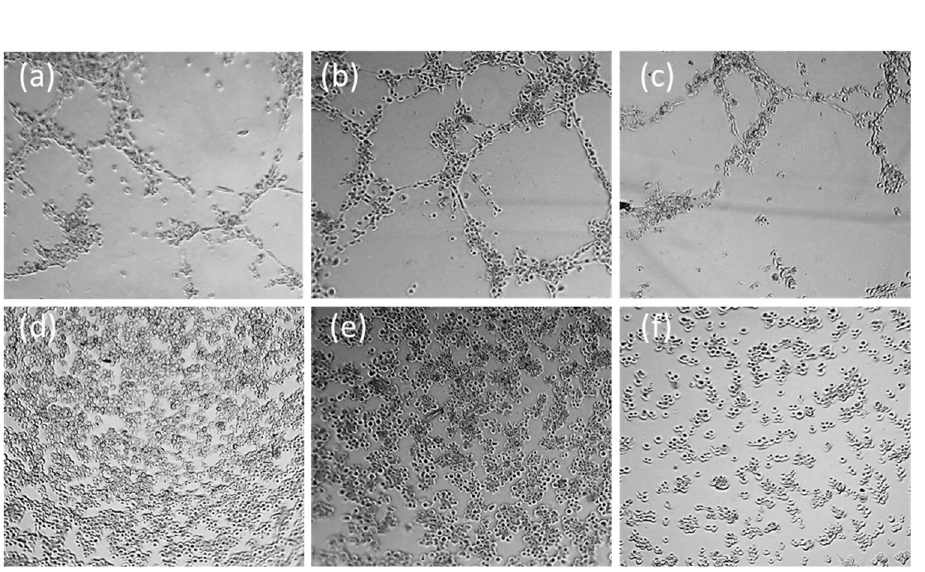
Figure 5. Antivascular effects of 21 ( a ), 22 ( b ), and 23 ( c ). Antiangiogenic effects of 21 ( d ), 22 ( e ), and 23 ( f ).